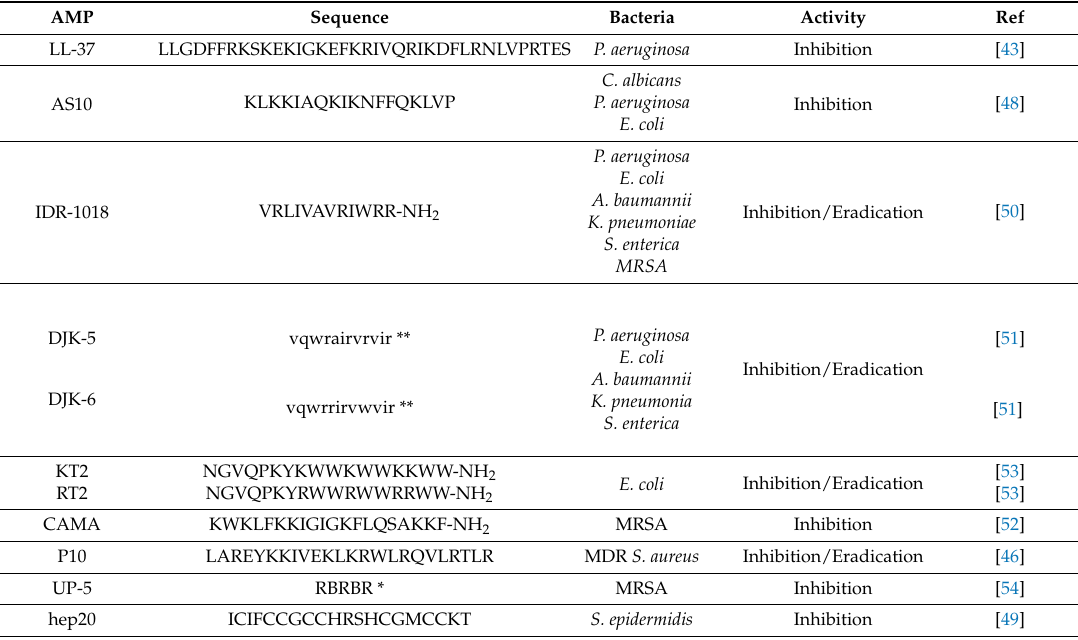
* B-biphenylalanine; ** lower case letters represent D -amino acids. Full species names are: Pseudomonas aeruginosa , Candida albicans , Escherichia coli , Acinetobacter baumannii , Klebsiella pneumoniae , Salmonella enterica , MRSA: methicillin-resistant Staphylococcus aureus , MDR: multidrug resistance S. aureus , Staphylococcus epidermidis